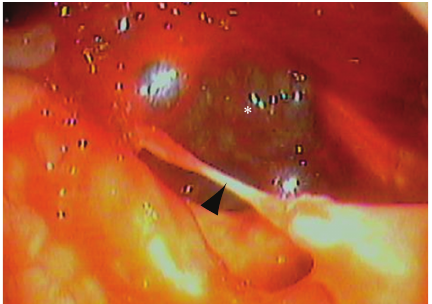
Figure 2: A fiberscopic image showing the bleeding ulcer in the left lateral to the posterior part of the oropharynx. Note that the left of the figure indicates the medial side, lower anterior, since this is a view through an otolaryngological pharyngolaryngeal fiberscope. An ulcer is found from the left lateral wall of the oropharynx to the hypopharynx (asterisk). A clot is observed within the ulcer. The remnant mucosa in the ulcerated area formed a bridge-like structure (arrow